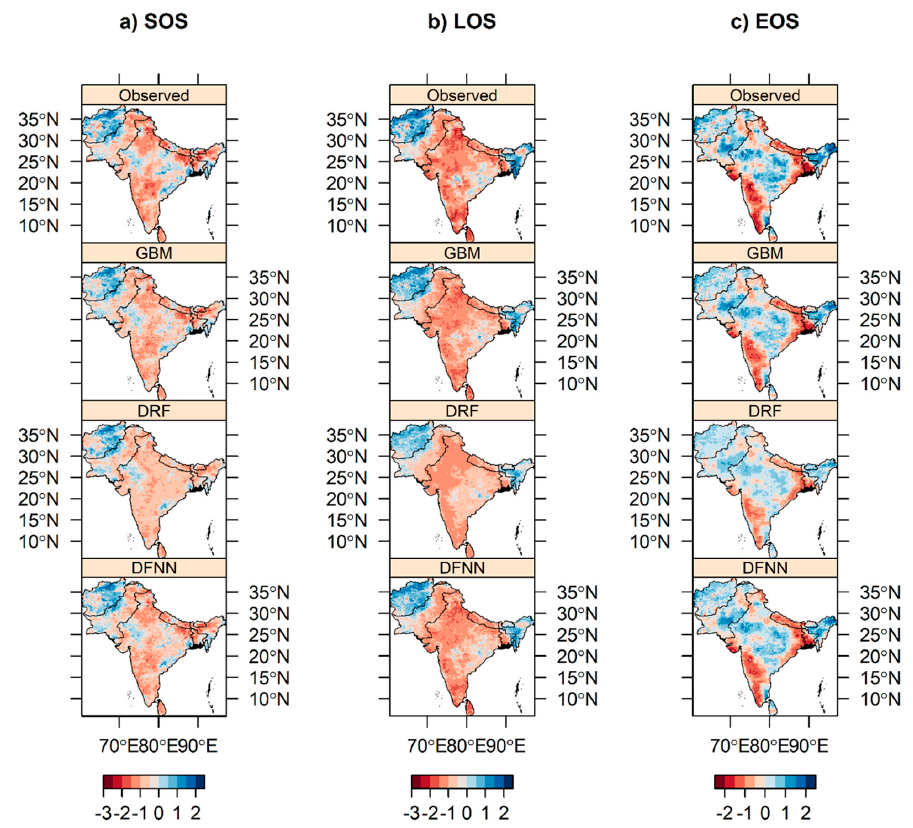
Figure 6. Comparison of deep learning-based spatiotemporal change of drought condition with two machine learning models at different phenology stages. Table 5. Comparison of the performance of deep learning and machine learning model on the test data set for the prediction of SMDI.